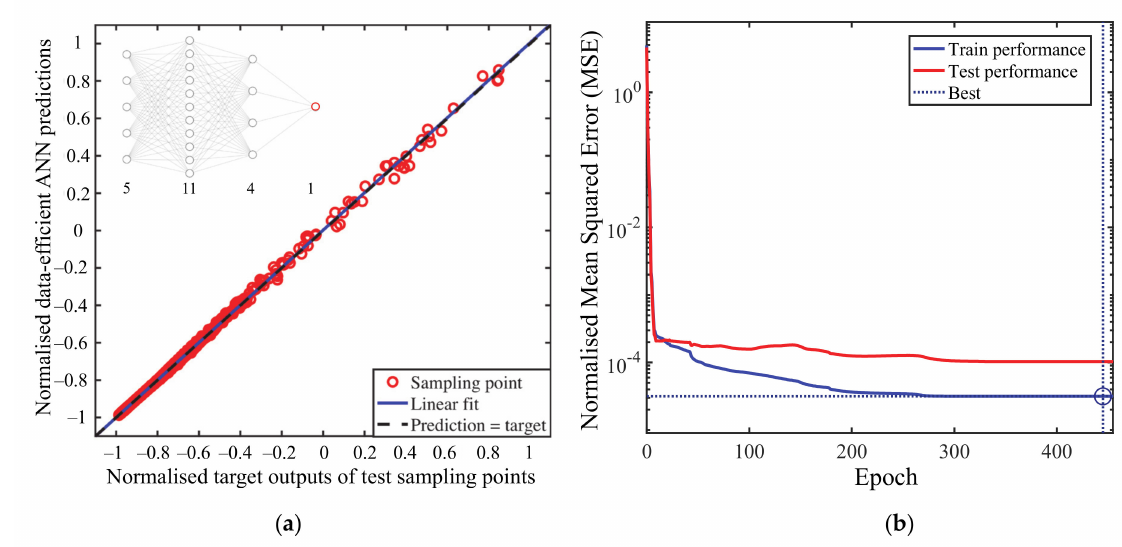
Figure 2. The results of the developed data-efficient neural network model with [5 11 4 1] architecture: ( a ) normalised data-efficient ANN predictions vs. target outputs (or polar lengths) with a Mean Squared Error (MSE) of 1.032 × 10 − 4 ; ( b ) the training process of the developed data-efficient ANN model, showing no overfitting and